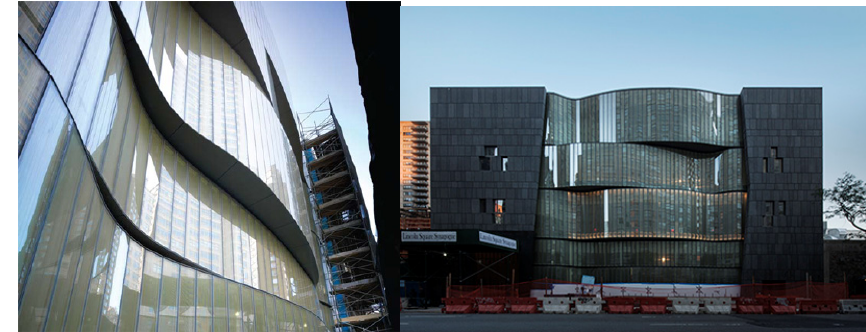
Figure 4. Lincoln Square Synagogue (Courtesy Front,